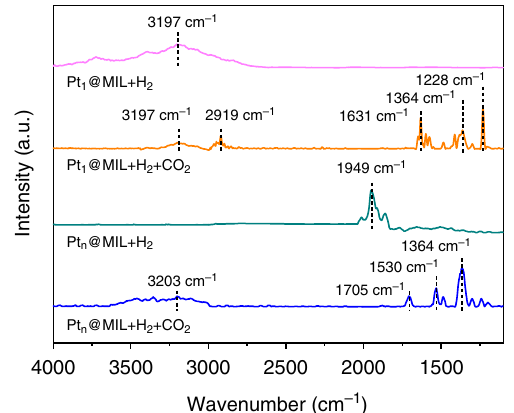
Fig. 3 Adsorption properties of reactants on Pt@MIL. In-situ DRIFTS spectra of Pt 1 @MIL and Pt n @MIL after the treatment with H 2 , as well as H 2 and CO 2 in sequence at 150